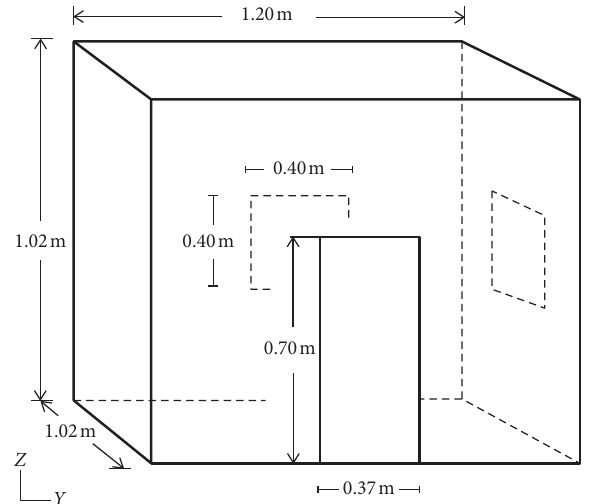
Figure 1: Geometry of the experimental domain including one door and two